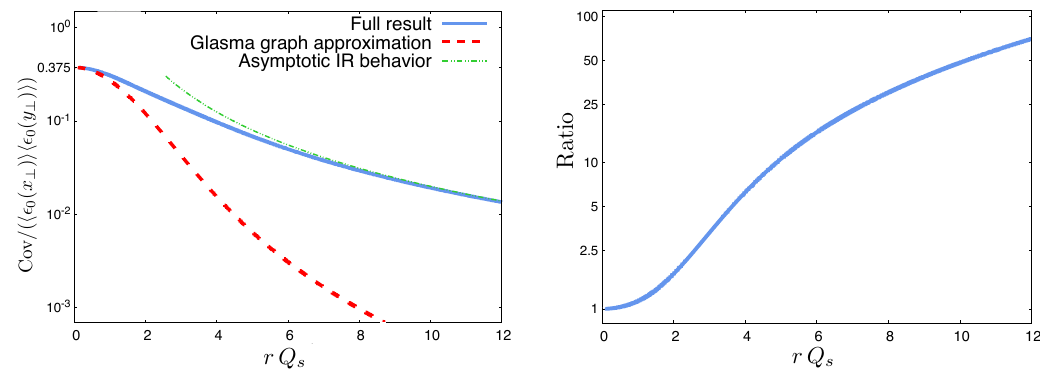
Figure 4 . LEFT: comparison of the normalized covariance of energy density (cid:15) Q s = Q s , N c = 3 in the exact analytical approach (blue full curve) and the Glasma Graph 1 2 approximation (red dashed curve). As a visual aid we also indicate the asymptotic behavior in the IR limit, which is 16 = [( N 2 1) r 2 Q 2 ] (green dot-dashed curve). RIGHT: ratio of exact analytical c (cid:0) s result to the Glasma Graph